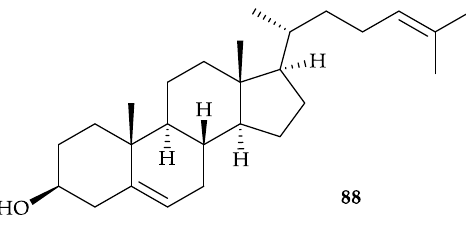
Figure 14. Structure of cholesta-5,24-dien-3β-ol ( 88 ).